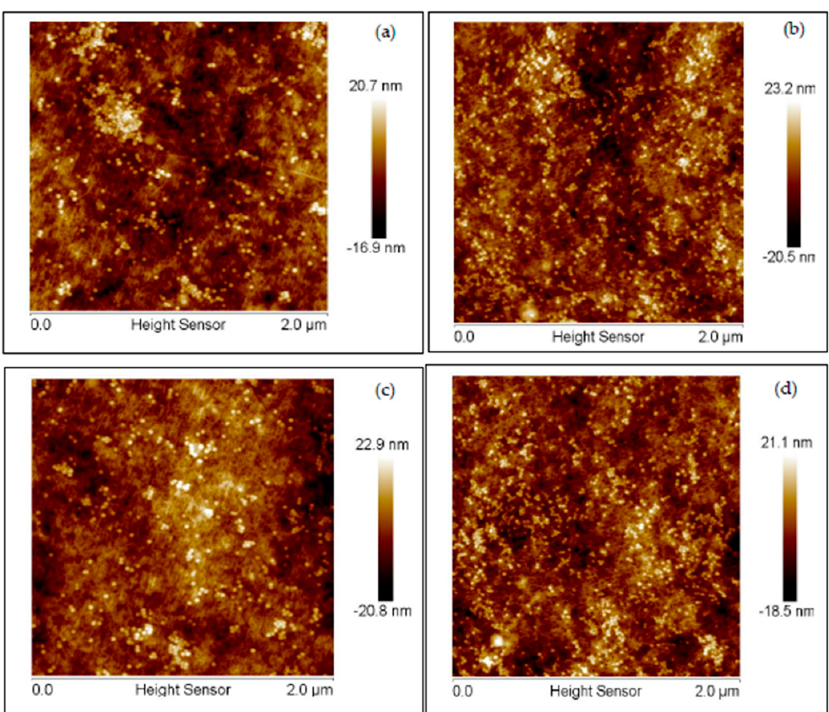
Figure 4. AFM images for modified membranes: ( a ) 1-min initiator immobilization and 1-h ATRP, ( b ) 5-min initiator immobilization and 1-h ATRP, ( c ) 1-min initiator immobilization and 4-h ATRP and ( d ) 5-min initiator immobilization and 4-h ATRP.